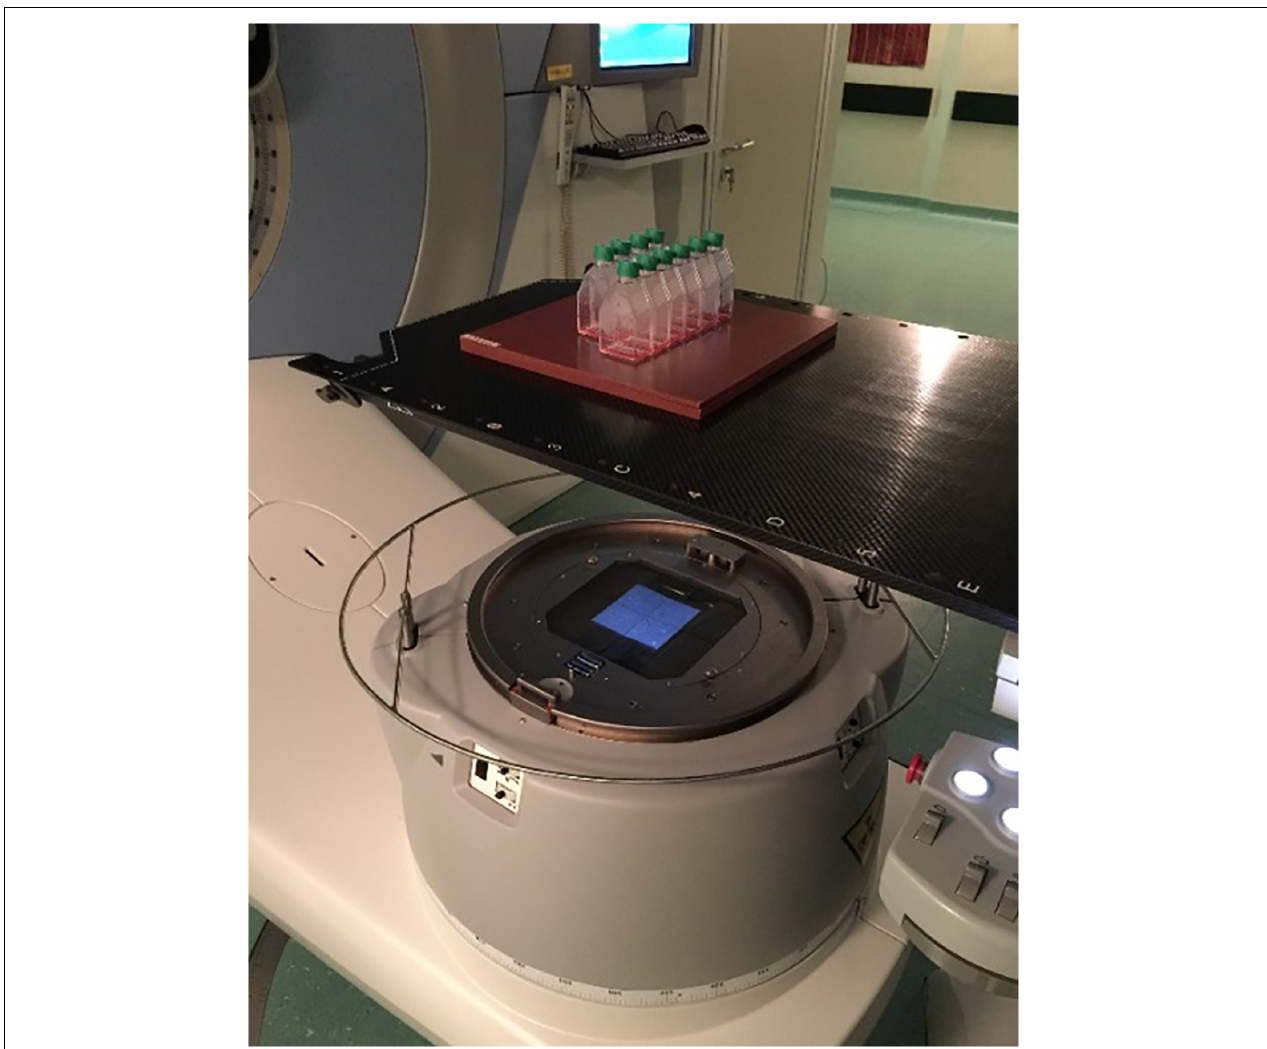
FIGURE 1 | Experimental setup used for T98G cell irradiations at radiotherapy